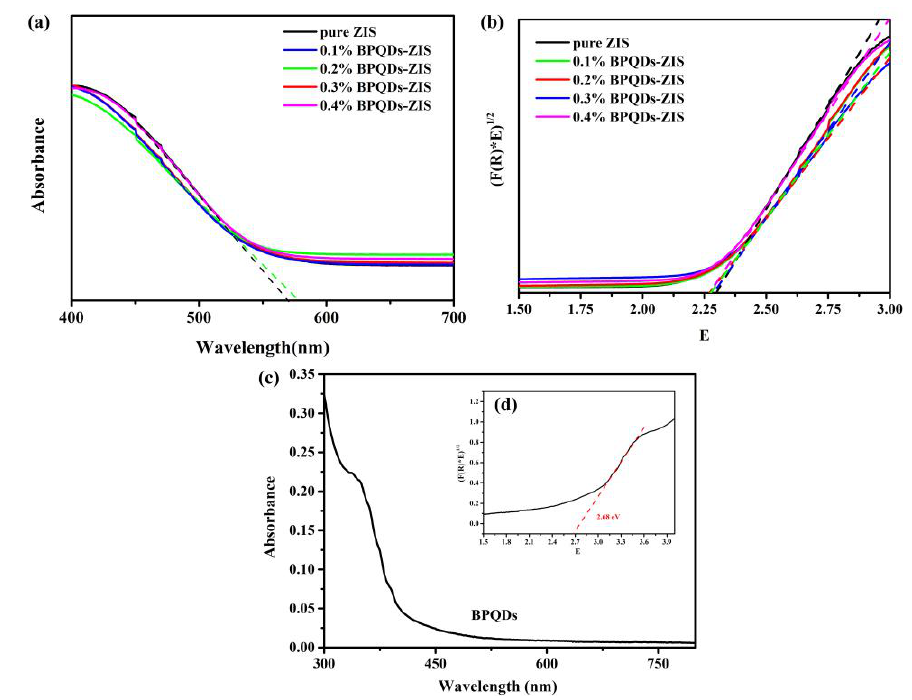
Figure 6. ( a ) Ultraviolet–visible light (UV–Vis) spectra of ZnIn 2 S 4 and the BPQD–ZIS samples; ( b ) Tauc plots of ZnIn 2 S 4 and the BPQD–ZIS samples; UV–Vis spectra ( c ) and the corresponding plot ( d ) of BPQDs.